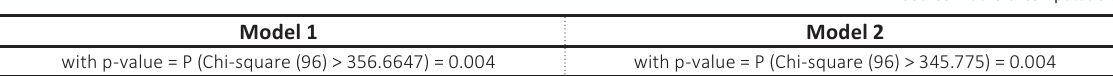
Source: Authors’ computations.